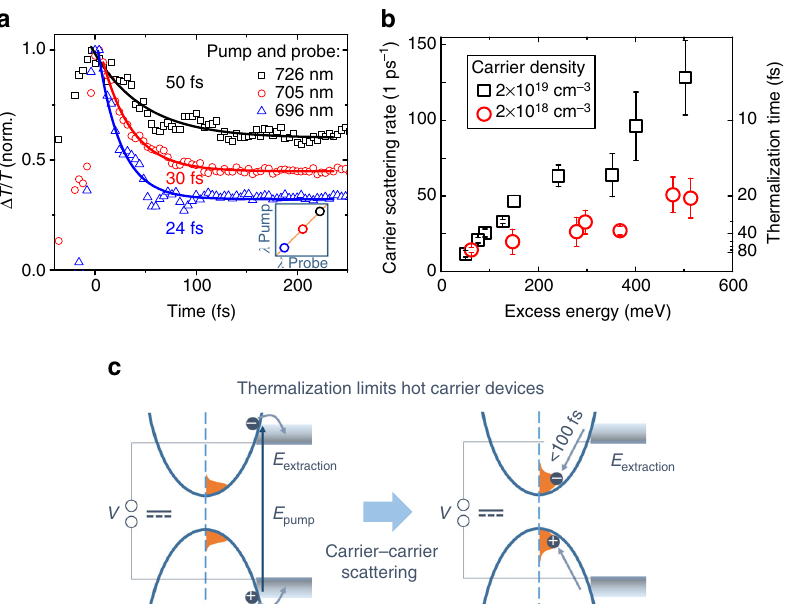
Fig. 4 Pump wavelength dependence of carrier thermalization. a Pump wavelength dependence of the initial decay of the diagonal signal at an excitation density of 2 × 10 19 cm − 3 . The shorter the pump wavelength, the faster the diagonal decays. The solid lines represent a mono-exponential fi t to the experimental data. b Carrier scattering rate vs excess energy over the bandgap at 1.63 eV. The scattering rates increase with excess energy. We observe that the scattering rate shows a fl uence dependence, which suggests that the main thermalization process is carrier-carrier scattering. The error bars represent the error of the mono-exponential decay time fi ts. c Schematic illustration of carrier thermalization under continuous wave illumination in a hot carrier extracting device. Due to the fast timescales of cooling compared to carrier recombination, there will always be a cold carrier population in a perovskite device. This population will quickly thermalize with any newly excited charge carriers. The thermalization time is therefore the limiting factor for hot carrier extracting